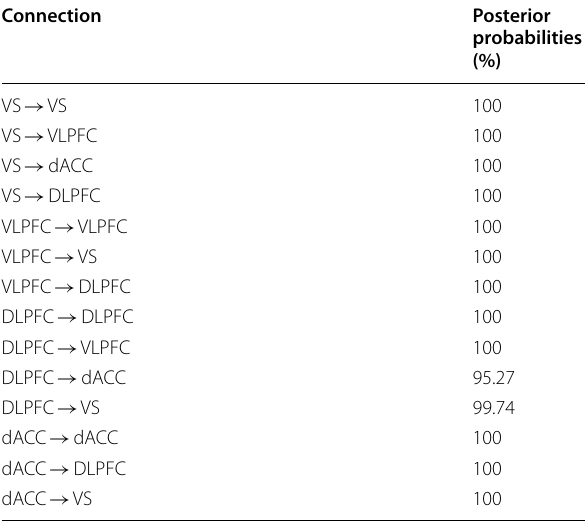
Table 3 Posterior probabilities of endogenous Table 4 Posterior probabilities and connection